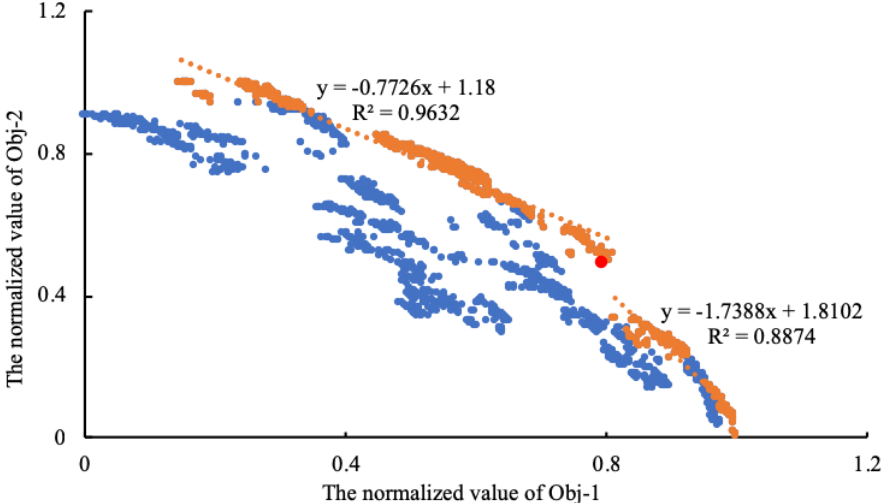
Figure 7. The two-dimensional scatter plots of Obj-1 and Obj-2’s normalized value. All the points indicate Pareto set, and among them, the orange points represent the Pareto frontier.